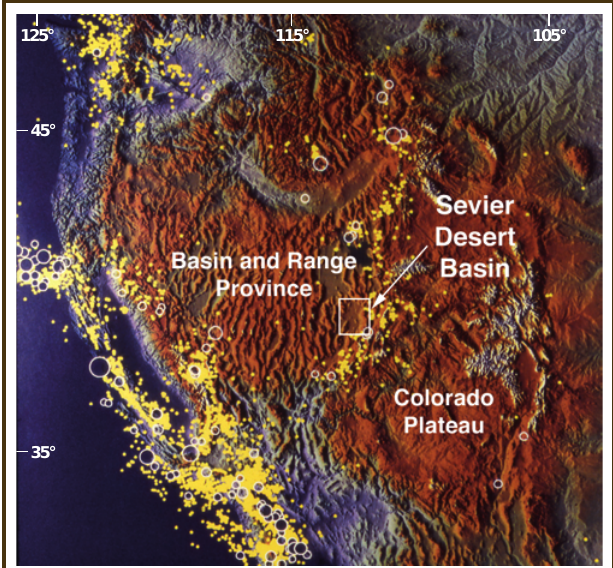
Figure 1. Regional physiography, seismicity, and location of the Sevier Desert basin in the western United States (from Simpson and Anders, 1992). White open circles are earthquakes greater than magnitude 6.0 from 1900 to 1975. Yellow dots are earthquakes greater than magnitude 2.5, occurring between 1970 and 1985. The north-trending band of seismicity adjacent to the Sevier Desert marks the eastern edge of the Basin and Range Province. Intense seismicity to the west and southwest, and including the western Basin and Range Province, corresponds with the diffuse transform plate boundary of which the San Andreas fault system is the most important